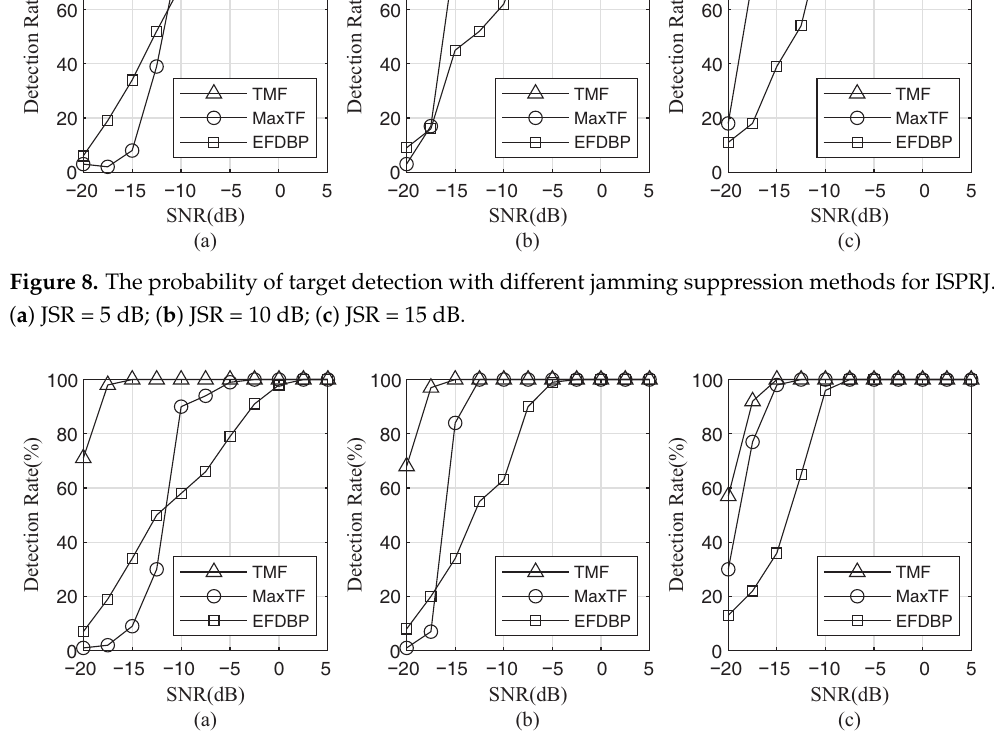
Figure 9. The probability of target detection with different jamming suppression methods for